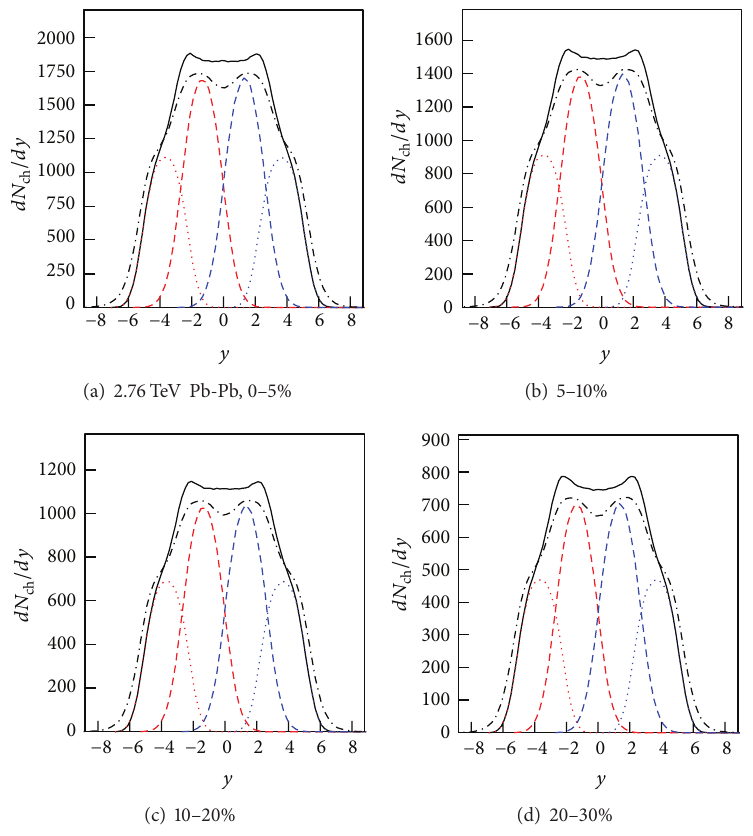
Figure 3: Extracted rapidity distributions of charged particles produced in Pb-Pb collisions at √𝑠 𝑁𝑁 = 2.76 TeV in the centrality intervals (a) 0–5%, (b) 5–10%, (c) 10–20%, and (d) 20–30%. The curves are our modelling results. Particularly, the dotted-dashed curves are pseudorapidity distributions taken directly from Figure